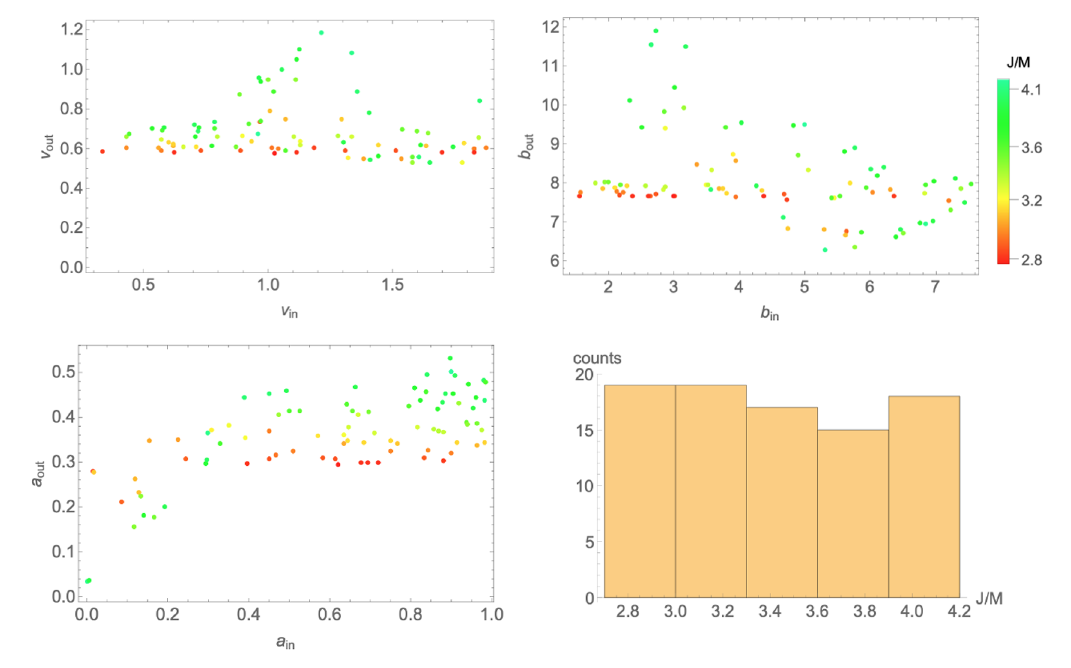
Figure 9 . 2 ! 1 ! 2 collisions: in 86 simulations, the outgoing parameters ( a out ; u out ; b out